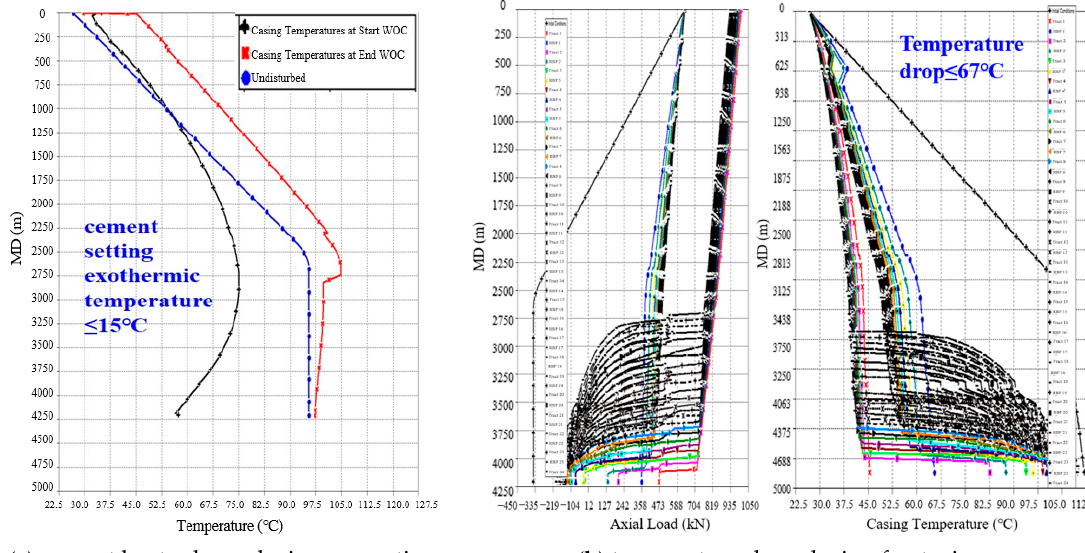
Figure 3. Effect of temperature on casing